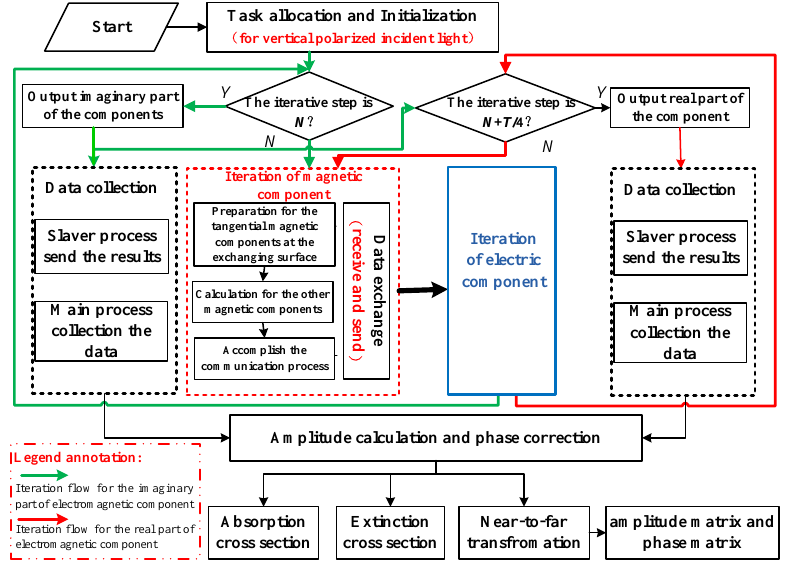
Figure 1. The basic flowchart of parallel FDTD computational model. calculation of the tangent of the right connecting surface in the k-1 sub-region. Furthermore, the tangential magnetic field components H x and H y at K=K 1 on the right surface are calculated and sent to the k+1 process, which is mainly used for the calculation of E x and E y components on the left connection surface of the k+1 process. At the same time, this process receives the tangential magnetic field component data of its left and right sides. In this scheme, the tangential electric field components E x and E y on both sides of the connection surface are need not to be exchanged. The reason is that the corresponding tangential electric field components E x and E y can be obtained on the basis of the magnetic field components after obtaining the tangential magnetic field components on the connection surface.